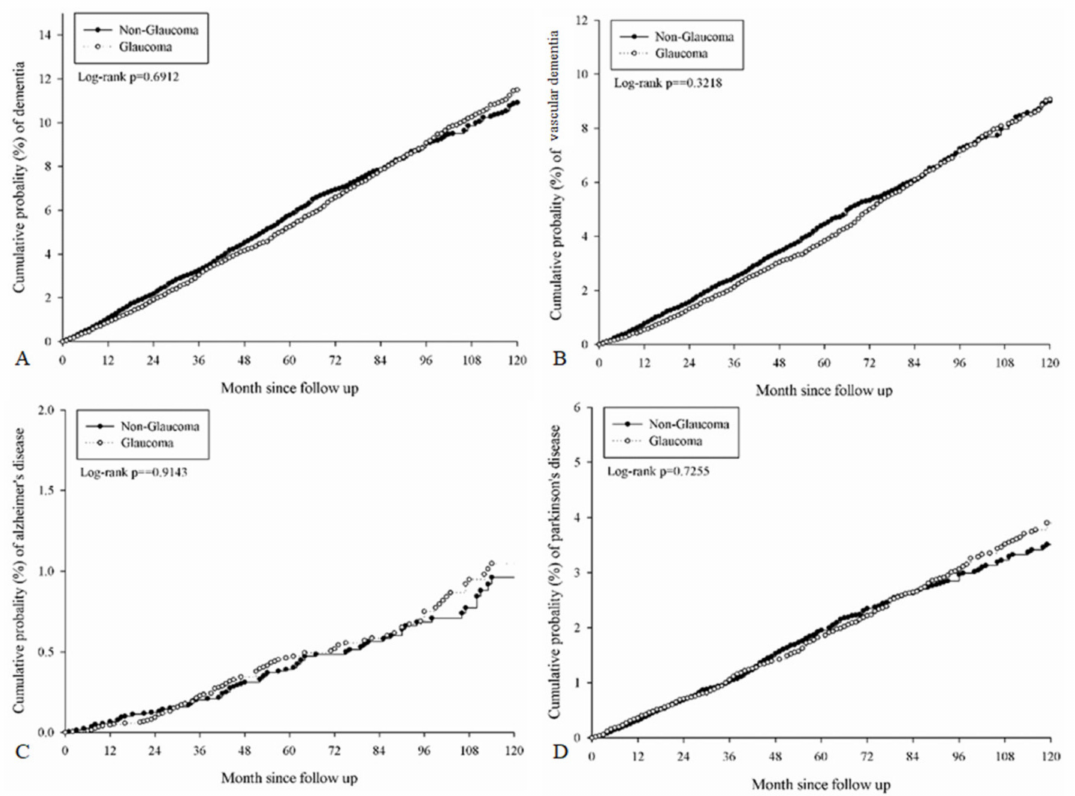
Figure 2. The Kaplan–Meier curves for the cumulative probability of each dementia. ( A ) Cumulative probability of any dementia. ( B ) Cumulative probability of vascular dementia. ( C ) Cumulative probability of Alzheimer’s disease. ( D ) Cumulative probability of Parkinson’s disease.